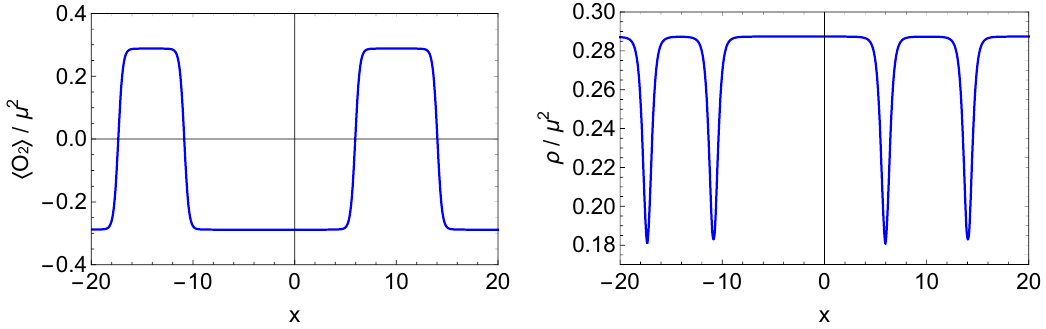
Figure 8 . The condensate (left) and the charge density (right) pro(cid:12)les obtained from each bulk solution for (cid:22) = 8 and L = 40. Each kink and anti-kink independently exist (a dilute gas of kinks and anti-kinks).